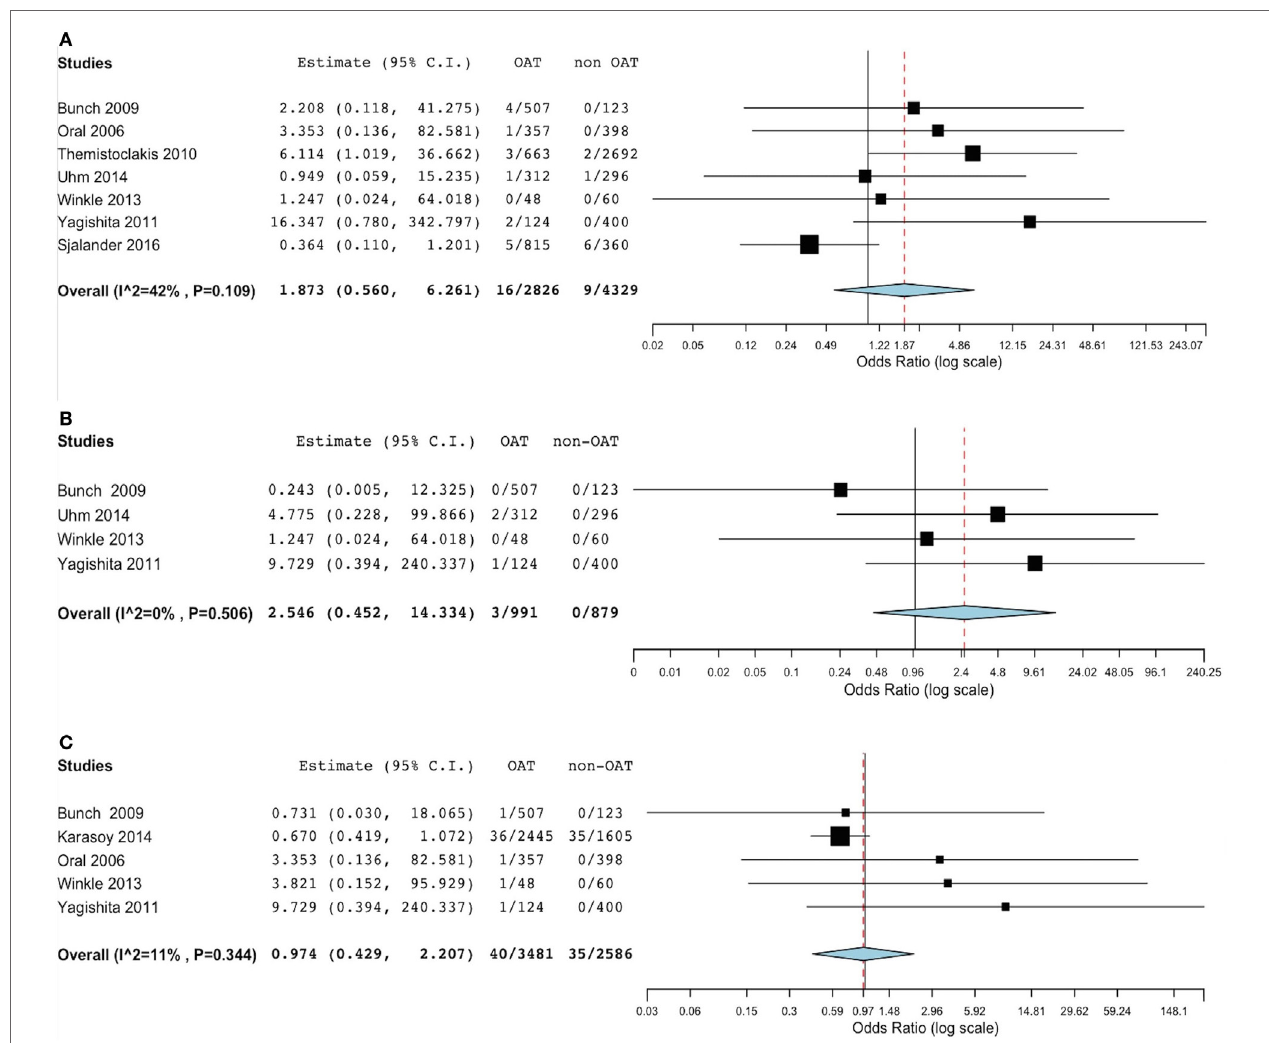
FiGUre 3 | Meta-analysis of difference in stroke, transient ischemic attack (TIA) and systemic embolic events. (a) Forest plot and summary effect of the difference in the incidence of stroke. (B) Forest plot and summary effect of the difference in the incidence of TIA. (C) Forest plot and summary effect of the difference in the incidence of systemic